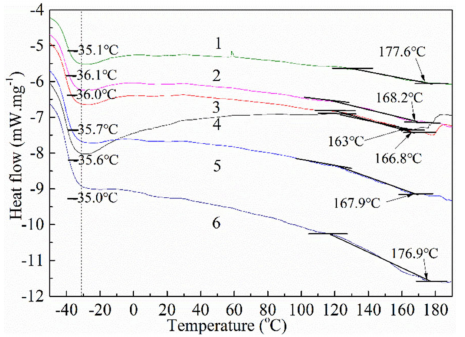
Figure 3. DSC of pure TPU (curve 1), the composite films prepared with 20 wt% of TPU and the graphene loadings of 0.6 wt% (curve 2), 2 wt% (curve 3), 3 wt% (curve 4), 4 wt% (curve 5) and 5 wt% (curve